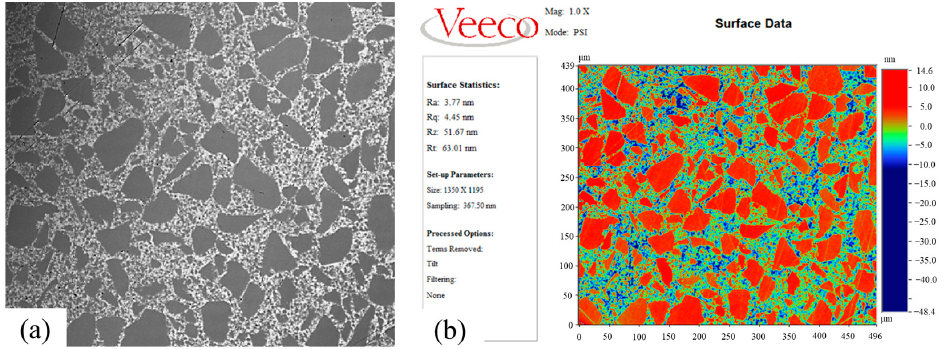
Figure 10. Microscopic imaging of the surface of internally supplied machining components. ( a ) Micrograph; ( b ) roughness.